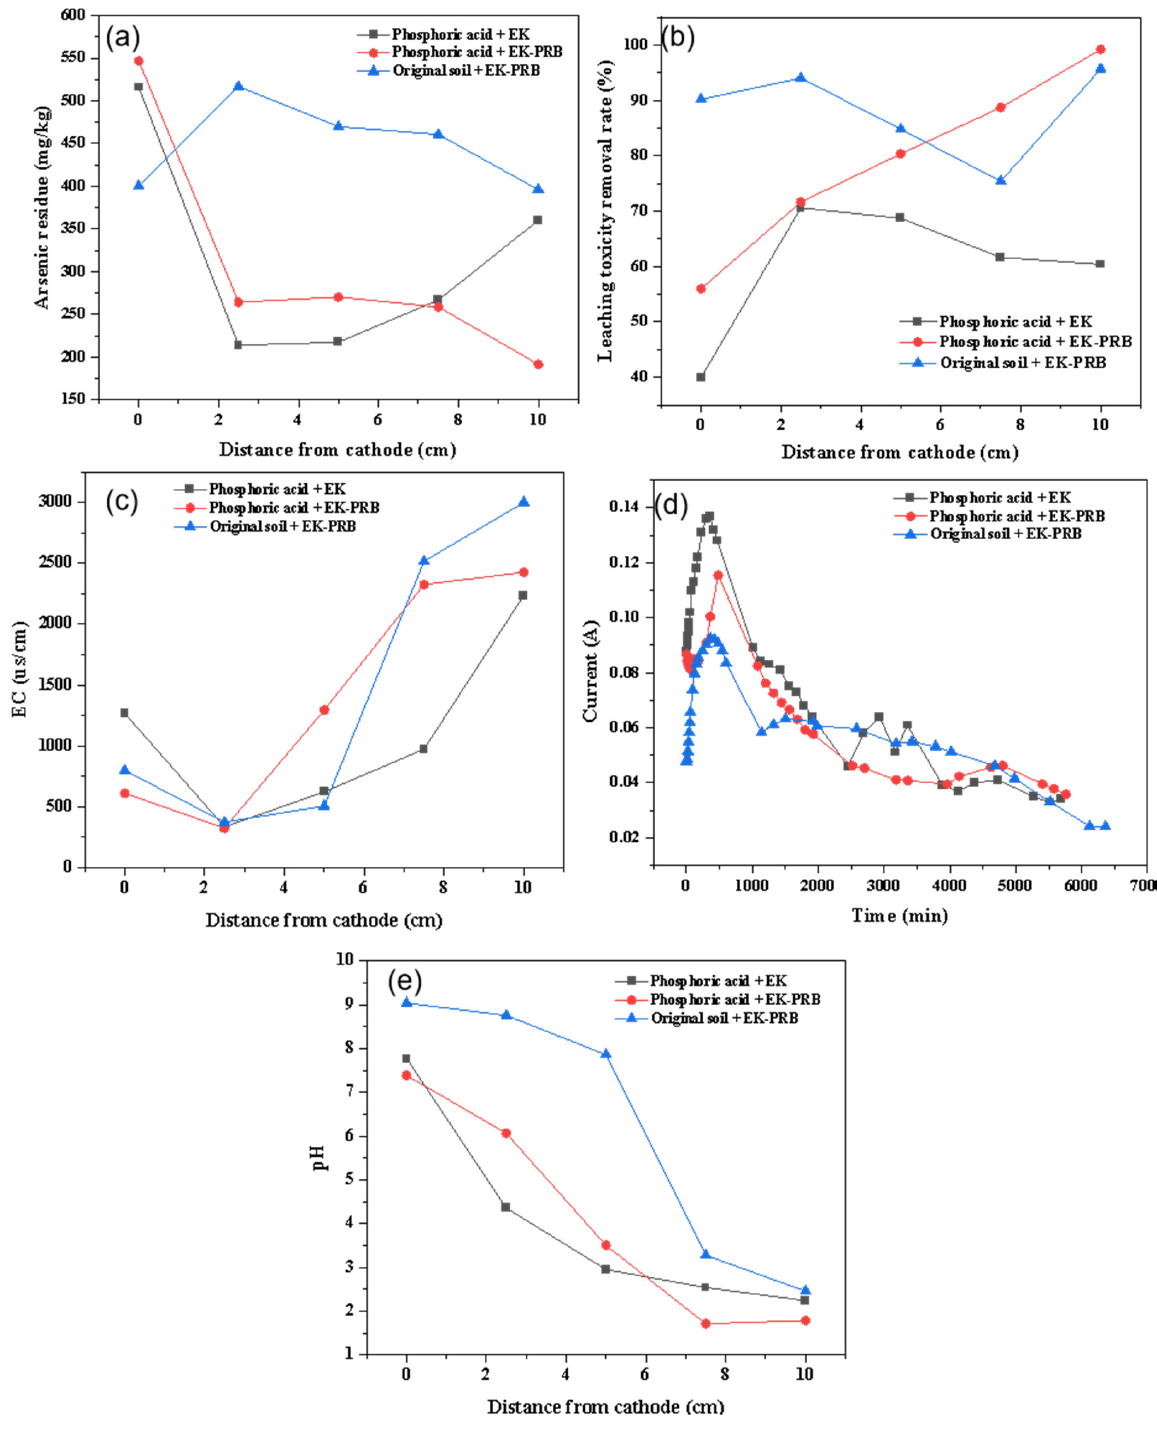
Figure 2. Effect of phosphoric acid for the remediation of arsenic contaminated soil by EK-PRB. Arsenic residue ( a ), leaching toxicity removal rate ( b ), EC ( c ), current ( d ) and pH ( e ).